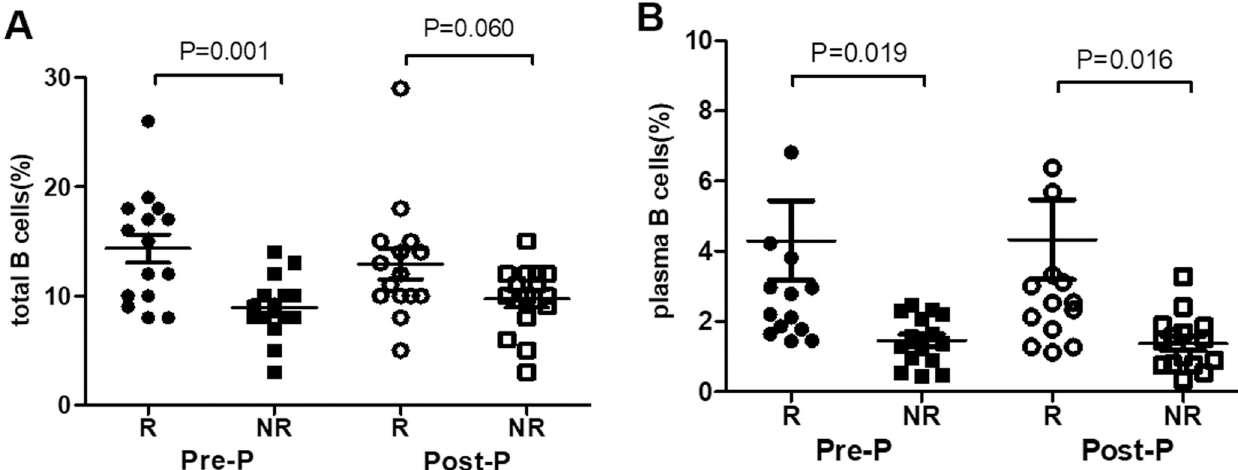
Fig 4. Comparison of total B and plasma B cells between R group and NR group during PEG-IFN treatment (A) Comparison of total B cells between IHCs who achieved HBsAg seroconversion (R group, n = 15) and who failed after matching the age, sex, and course of treatment (NR group, n = 15) at the time point before HBsAg seroconversion was detected (Pre-P) and at the time point when HBsAg seroconversion was detected (Post-P). (B) Comparison of plasma B cells between IHCs who achieved HBsAg seroconversion (R group, n = 15) and who failed after matching the age, sex, and course of treatment (NR group, n = 15) at Pre-SC, and